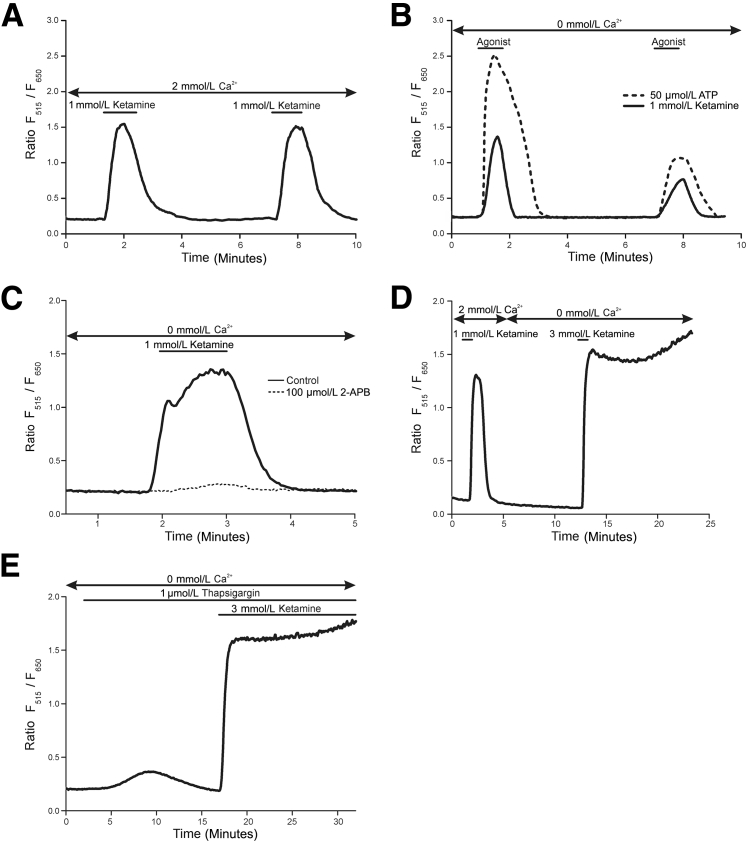
Normal (nonimmortalized) human urothelial (NHU) cell cystolic [Ca2+] was elevated by the release of stores from the endoplasmic reticulum in response to ketamine exposure. A: The repeated administration of 1 mmol/L ketamine to NHU cells in the presence of 2 mmol/L extracellular [Ca2+] resulted in repeated transient increases in cytosolic [Ca2+], with no sign of reduced intensity in subsequent transients. B: The source of the calcium transient was elucidated by performing repeated challenges of urothelial cells with 1 mmol/L ketamine (solid line) and 20 μmol/L ATP (dashed line) in the absence of extracellular calcium. An initial treatment with either ketamine or ATP generated a calcium transient showing that, in both cases, calcium was released from internal stores. A second stimulation triggered a significantly attenuated transient in response to either ketamine or ATP, indicating incomplete refilling of the internal stores. C: Pretreatment of urothelial cell cultures with 100 μmol/L 2-APB produced complete inhibition (dashed line) of the 1 mmol/L ketamine-induced calcium release (solid line). D: The source of the sustained [Ca2+] elevation was confirmed as internal by stimulating the cells with 3 mmol/L ketamine in the absence of exogenous calcium. E: Thapsigargin was used to inhibit SERCA pumps and effectively empty the ER by allowing Ca2+ ions to leak out. The 3 mmol/L ketamine-induced elevation in cytosolic [Ca2+] persisted. Images are traces representative of triplicate experiments.